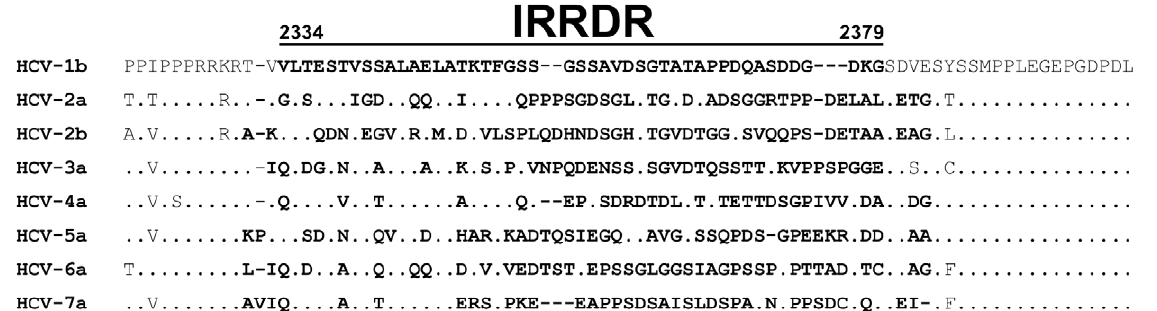
Figure 5. Sequence alignment of IRRDR (interferon/ribavirin resistance-determining region) and its upstream and downstream sequences of different HCV genotypes. The residues in the region that corresponds to IRRDR of HCV-1b [11] are written in boldface letters. Dots indicate residues identical to the HCV-1b sequence. References of aligned sequences are: HCV-1b, El-Shamy et al. [11]; HCV-2a and -2b, Murakami et al. [8]; HCV-3a, X76918; HCV-4a, Y11604; HCV-5a, AF064490; HCV-6a, D84262; HCV-7a, EF108306.